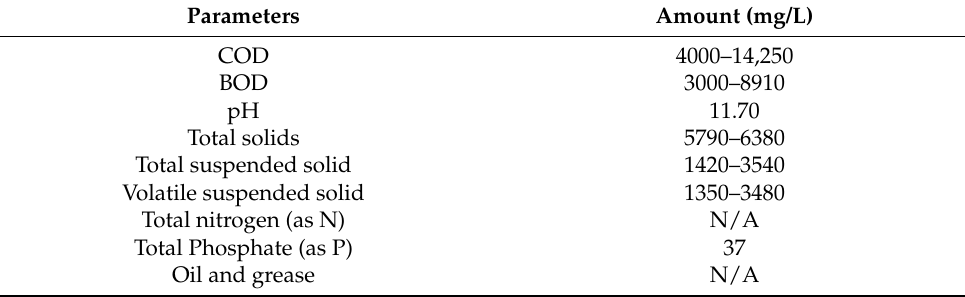
Table 1. Wastewater characteristics used in this study.